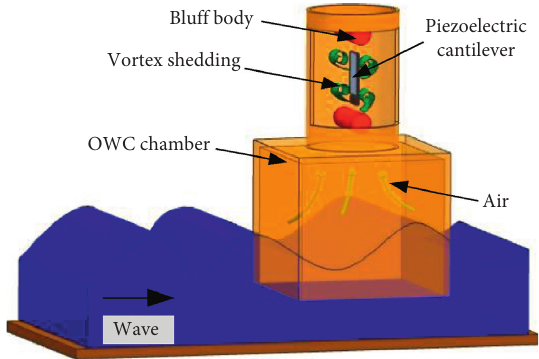
Figure 1: Schematic of the piezoelectric cantilever beam generator with OWC harvesting the ocean wave